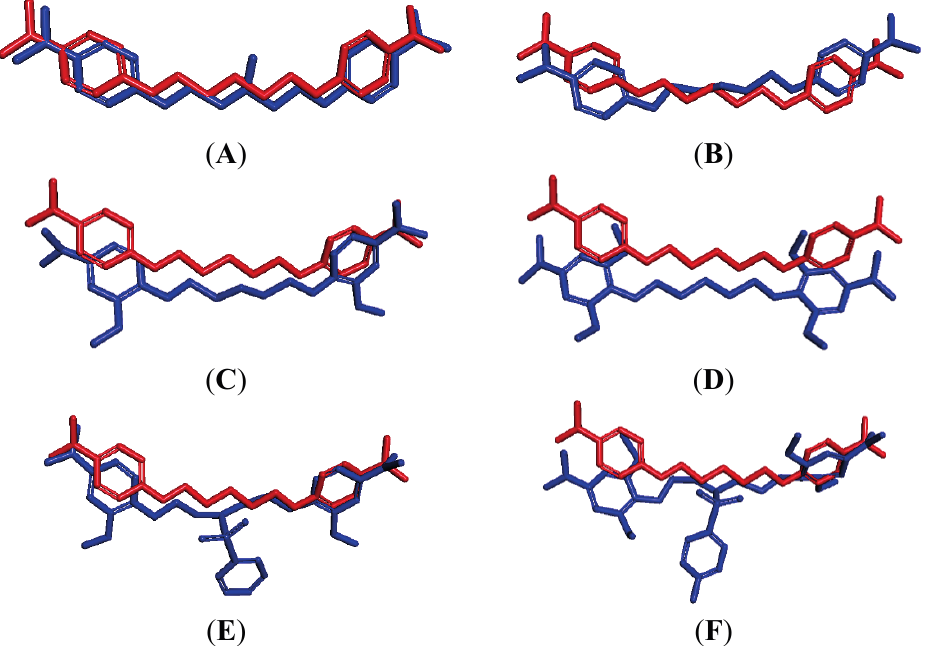
Figure 4. Illustration of conformational differences between pentamidine and its analogs in the DNA minor groove. Pentamidine is shown in red, and the ligands are shown in blue. ( A ) compound 1 ; ( B ) compound 6 ; ( C ) compound 7 ; ( D ) compound 9 ; ( E ) compound 12 ; ( F ) compound 13